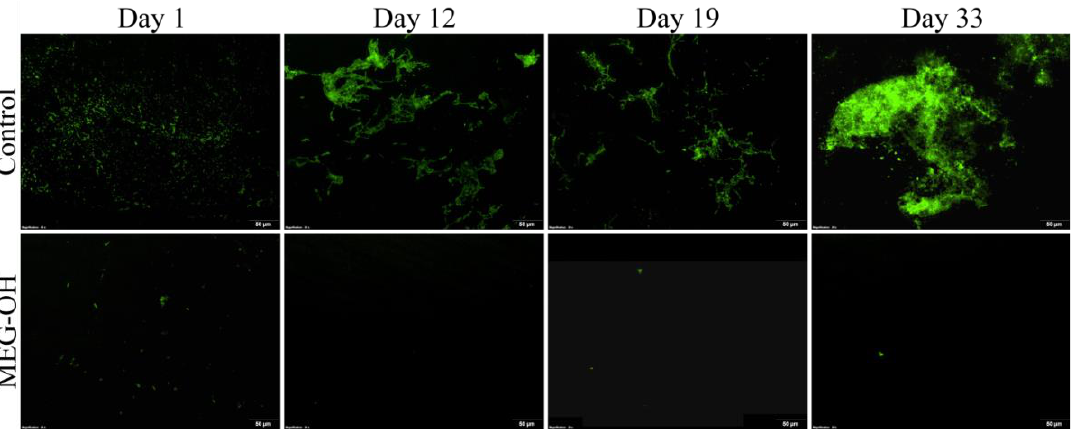
Figure 5. Fluorescence images of control, and MEG-OH coated surfaces that were exposed to static LB containing S. aureus for 1 day, then at days 12, 19, and 33 under flow of 2 g/L concentration LB